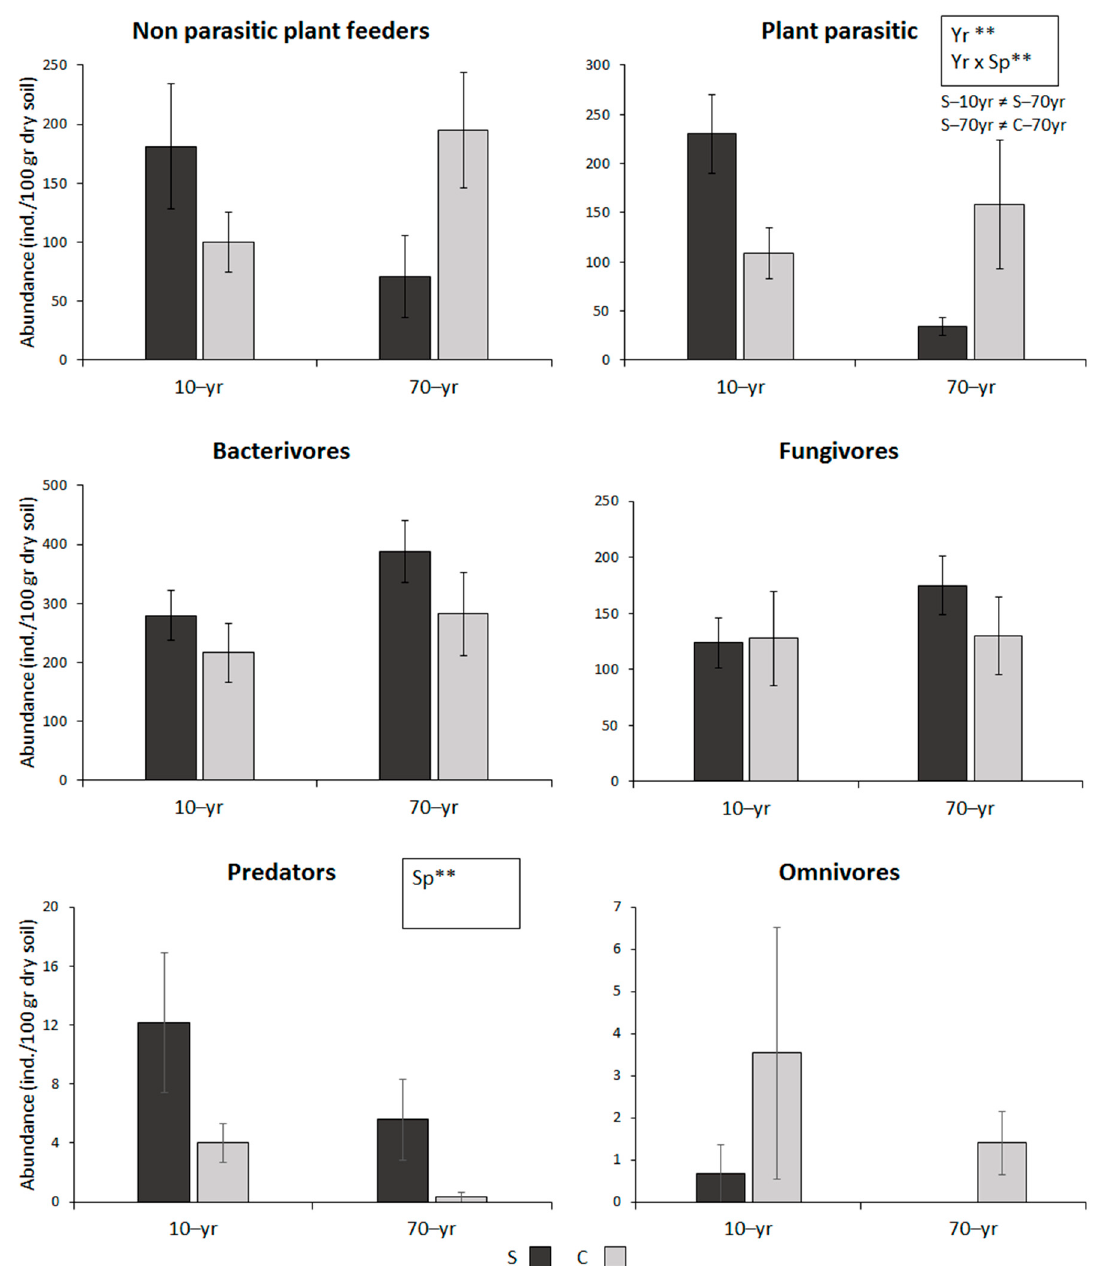
Figure 1. Abundance of nematode trophic groups (mean ± SE) in the rhizospheres of the alien Solanum elaeagnifolium (S, dark grey bars) and the native Cichorium intybus (C, light grey bars) in recently (10yr) and historically (70yr) invaded sites. Results of PERMANONA, when significant, are indicated in boxes (**: p < 0.01). In case of significant interaction effect, the significant differences revealed by pair-wise tests are indicated.